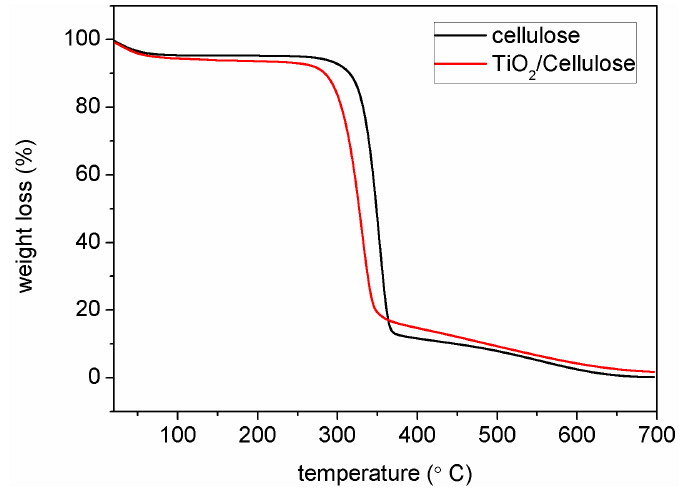
Figure 3. Thermal gravimetric analysis (TGA) of cellulose paper and TiO 2 /cellulose composite film.